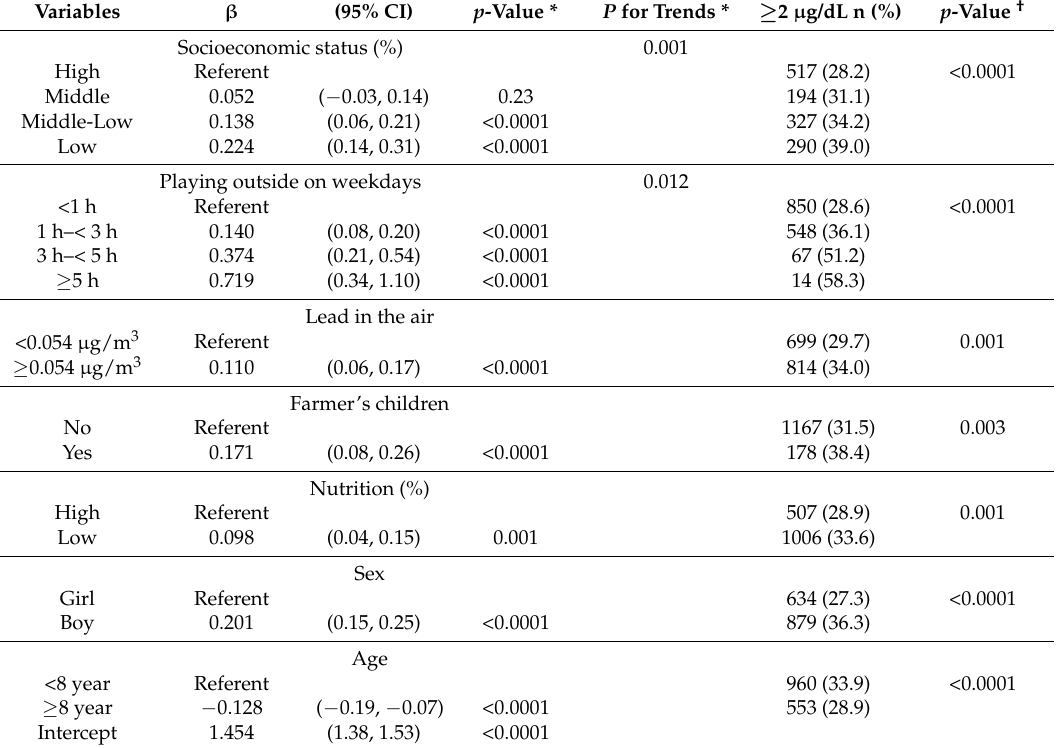
Table 2. Association Between Blood Lead and Potential Lead Exposure Sources and Epidemiologic Characteristics of Children with Blood Lead Levels ≥ 2 µ